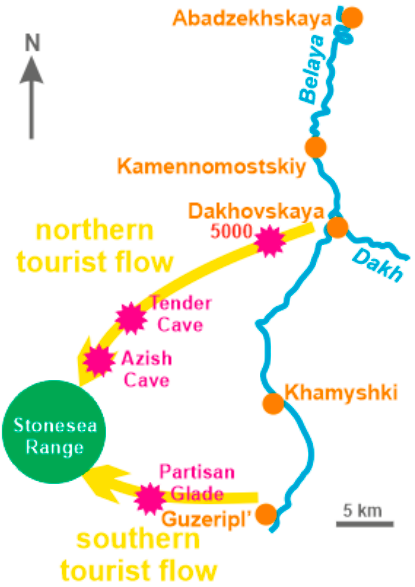
Figure 5. Relations of the analyzed dispersed geoheritage points to tourism activities in the study area.